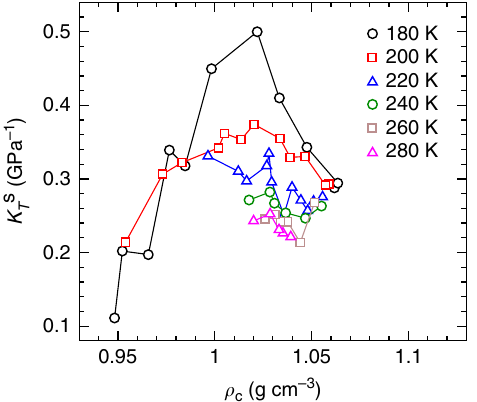
Fig. 9 Isothermal compressibility of the nanodroplet core. Isotherms of K s T versus ρ c for 200 ≤ N ≤